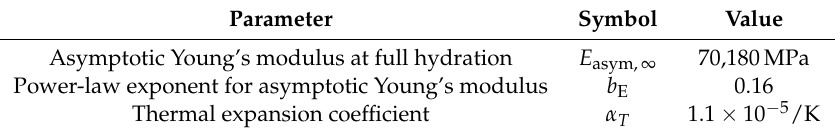
Table 8. Parameters for the incremental stress-strain relationship and thermal expansion